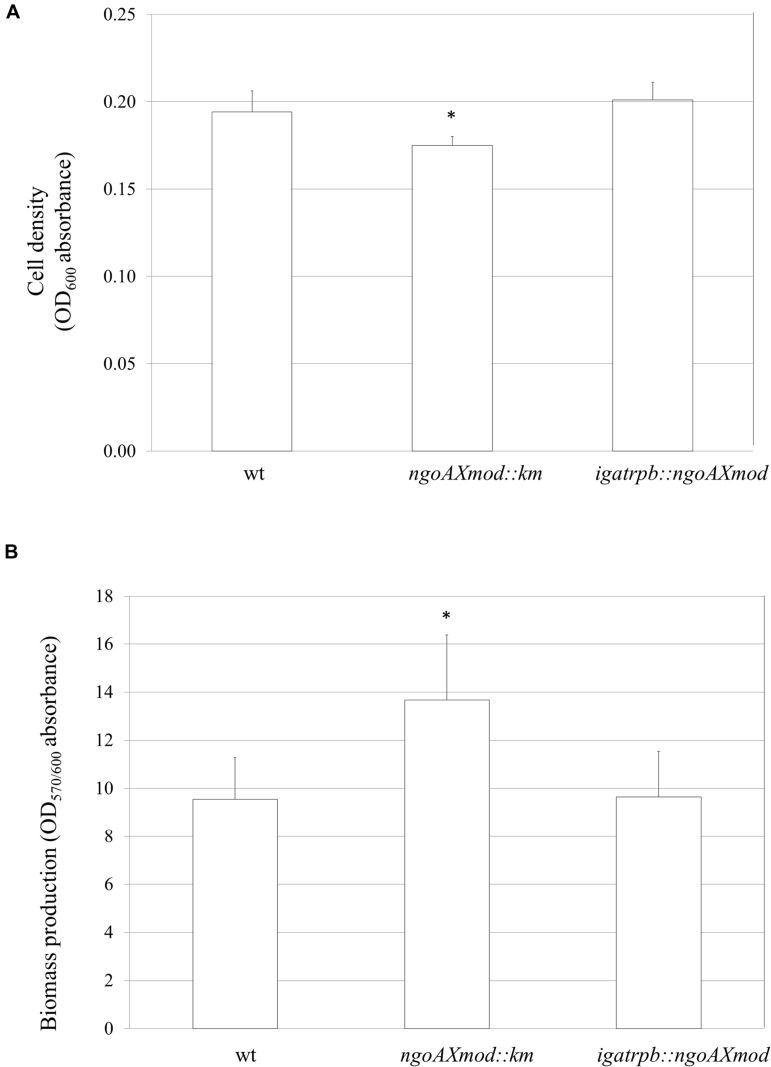
Growth and biofilm biomass of ngoAXmod::km and igatrpb::ngoAXmod N. gonorrhoeae mutants compared to the wt strain. Measurements were performed by crystal violet staining after a 24-h growth without shaking. (A) Biofilm and planktonic cell growth was measured at absorbance OD600; (B) Biomass production: ratio of cells that forms biofilm (OD570) versus total grown cells (OD600). Asterisks represent statistical significant differences in comparison to the wt strain (P < 0.05).